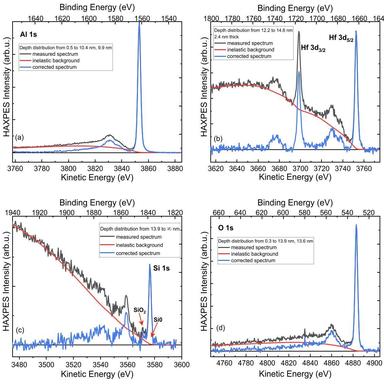
QUASES-Analyze IBA for sample A1: HfO2 (2.4 nm) buried under Al2O3 (9.9 nm). The elemental distributions for the Al 1s and Hf 3d peaks support anticipated thickness of the sample. Si 1s and O 1s suggest a thicker sample, with possibly an oxidized layer of contamination. A SiO2 component may be visible in the Si 1s spectrum.